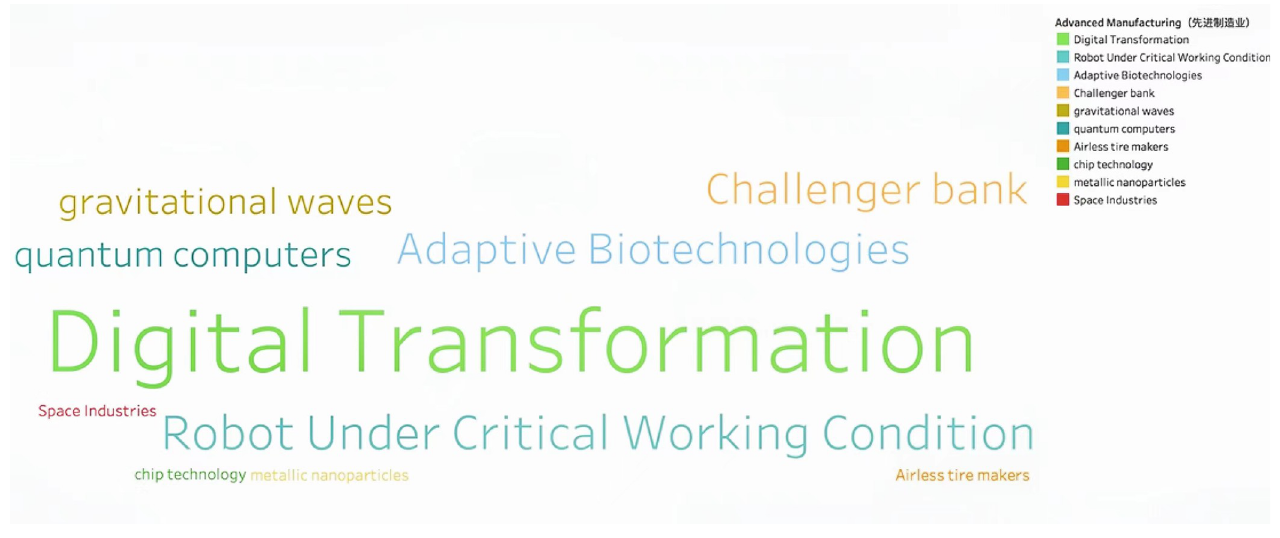
Fig 8. Word cloud diagram in the field of Advanced